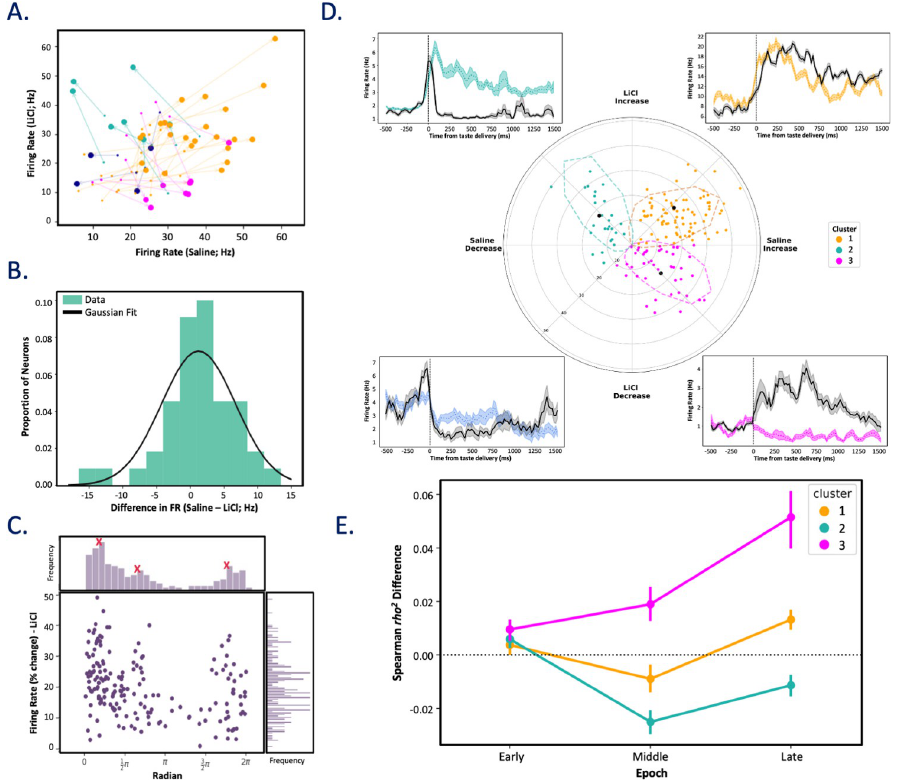
Fig 8. Neurons held across post-LiCl and post-saline tasting sessions produce distinct clusters of taste response profiles. (A) Firing rate trajectories for single neurons before (small circles) and after (large circles) taste delivery to the presentation of citric acid reveal condition-specific (sickness–y-axis, healthy–x-axis) taste response properties. Responses are colored with respect to angle of the response trajectory (0–90˚, 90–180˚, 180–270˚, and 270–360˚ are yellow, teal, magenta, and blue, respectively), which highlights the distinct natures (excitatory, inhibitory) of responses in each condition. (B) A comparison of pre-stimulus activity suggests that post-injection firing rates did not differ between conditions: The peak of the distribution of saline-LiCl differences hovers around 0, and the distribution is fit well by a Gaussian (Kolmogorov–Smirnov test; p = 0.98); these facts suggest 0 difference (plus random noise). (C) A population response histogram ( n = 44) held neurons depicting each neuron’s taste response (change from pre taste) as a function of vector direction in panel B confirms the presence of 3 unique peaks of vector direction (peaks indicated with red Xs). (D) A GMM was used to cluster cells based on response magnitude and trajectory. This analysis confirmed distinct cluster responses, revealed here in a polar plot (dashed lines denote 95% confidence interval of cluster classification with respect to black-filled centroids). PSTHs for representative neurons are seen adjacent to the detected clusters, indicating taste responses post-saline (black) and post-LiCl (colored, cluster specific). (E) Cluster 3 (magenta) neurons reliably and selectively experience a sickness-induced increase in palatability-relatedness in the late epoch (nonparametric 2-way repeated-measure ANOVA; ��� p < 0.001). Vertical lines represent SEMs. Data underlying this figure can be found in S7 Data. GMM, Gaussian mixture model; LiCl, lithium chloride; PSTH, peristimulus time